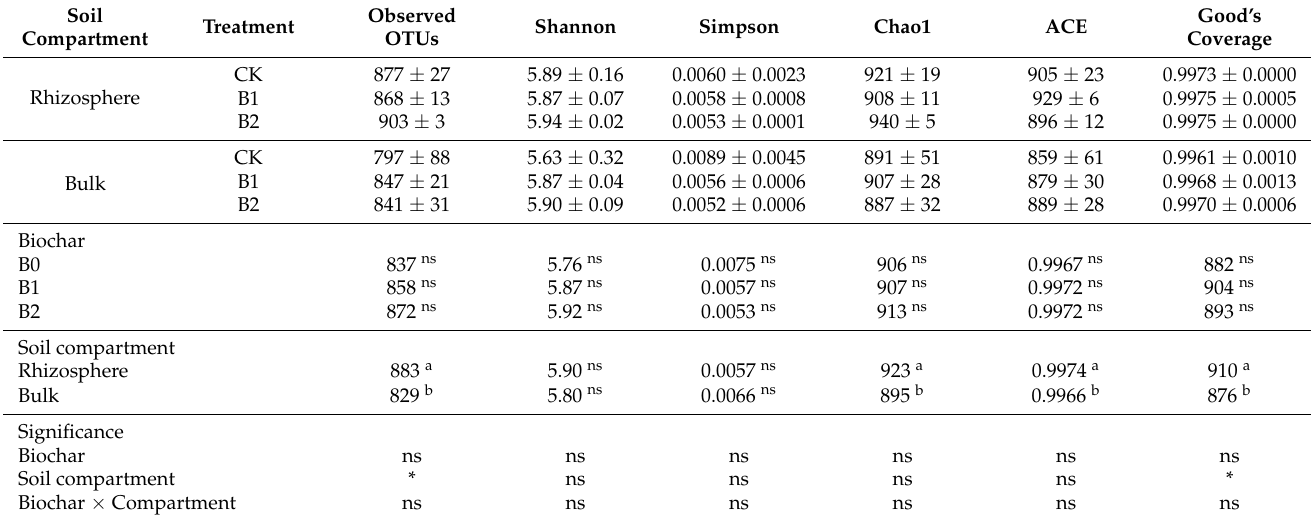
Table 3. Effects of biochar and nitrogen fertilizer application on species richness and diversity of bacterial communities in the rhizosphere and bulk soils of